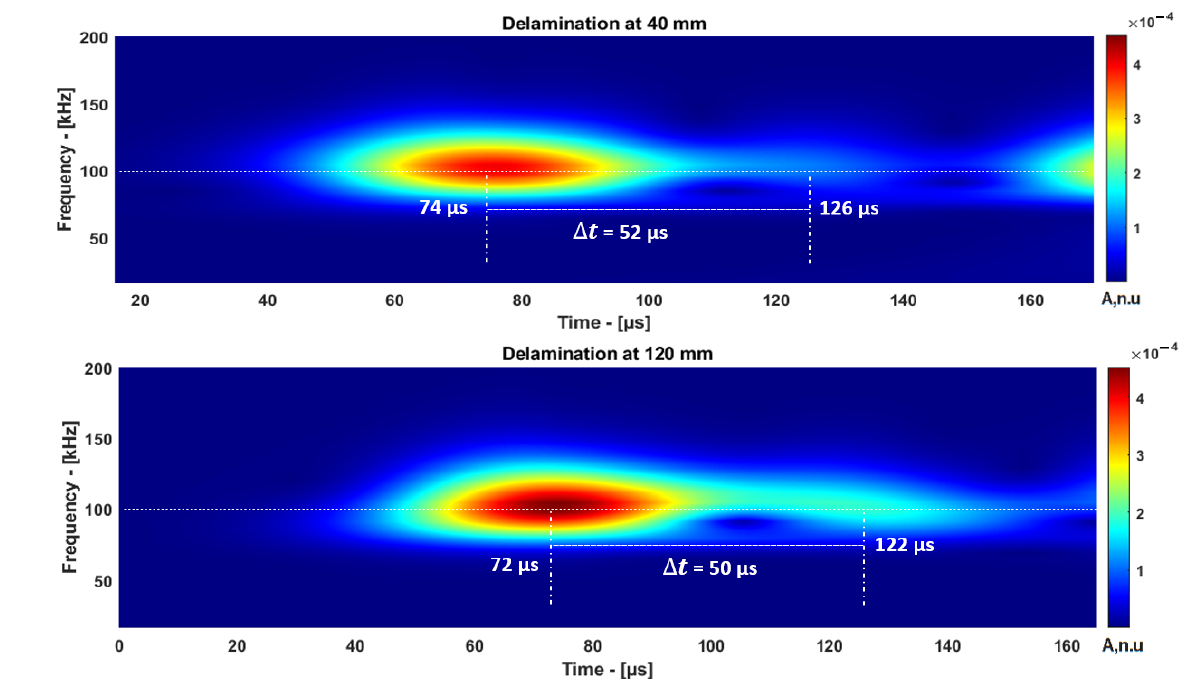
Figure 10. The ToF estimation of reflected A 0 mode received at 80 mm: delamination at 40 mm ( a ) and 120 mm ( b ).